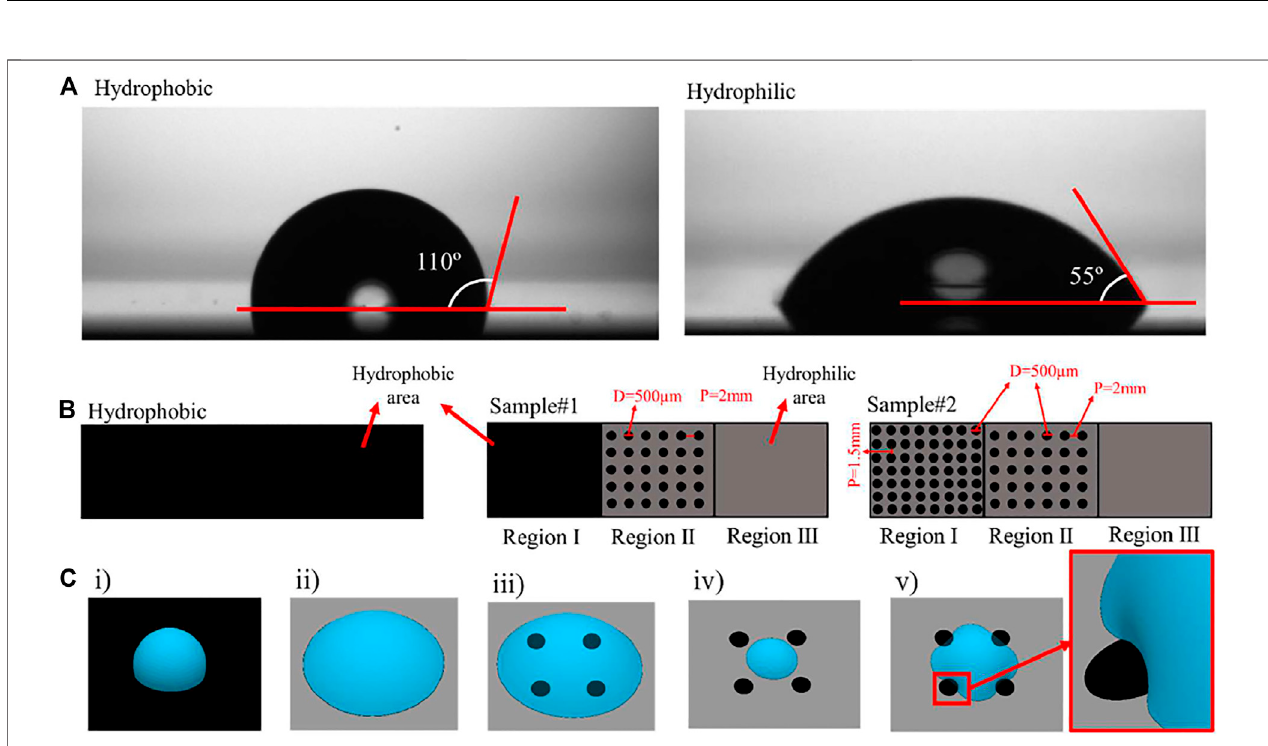
FIGURE 4 | (A) Contact angles of hydrophobic (C 4 F 8 ) and hydrophilic (Silicon) parts (B) schematic representations of Sample#1 and Sample#2 (C) different scenarios for droplets regarding contact angles.